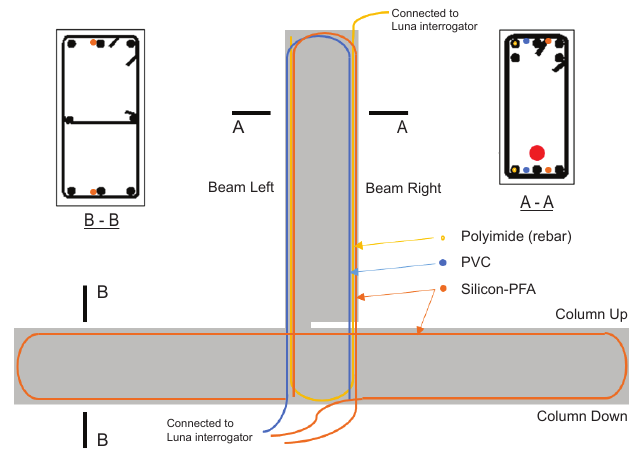
Figure 3. Fiber-optic cable layout in the